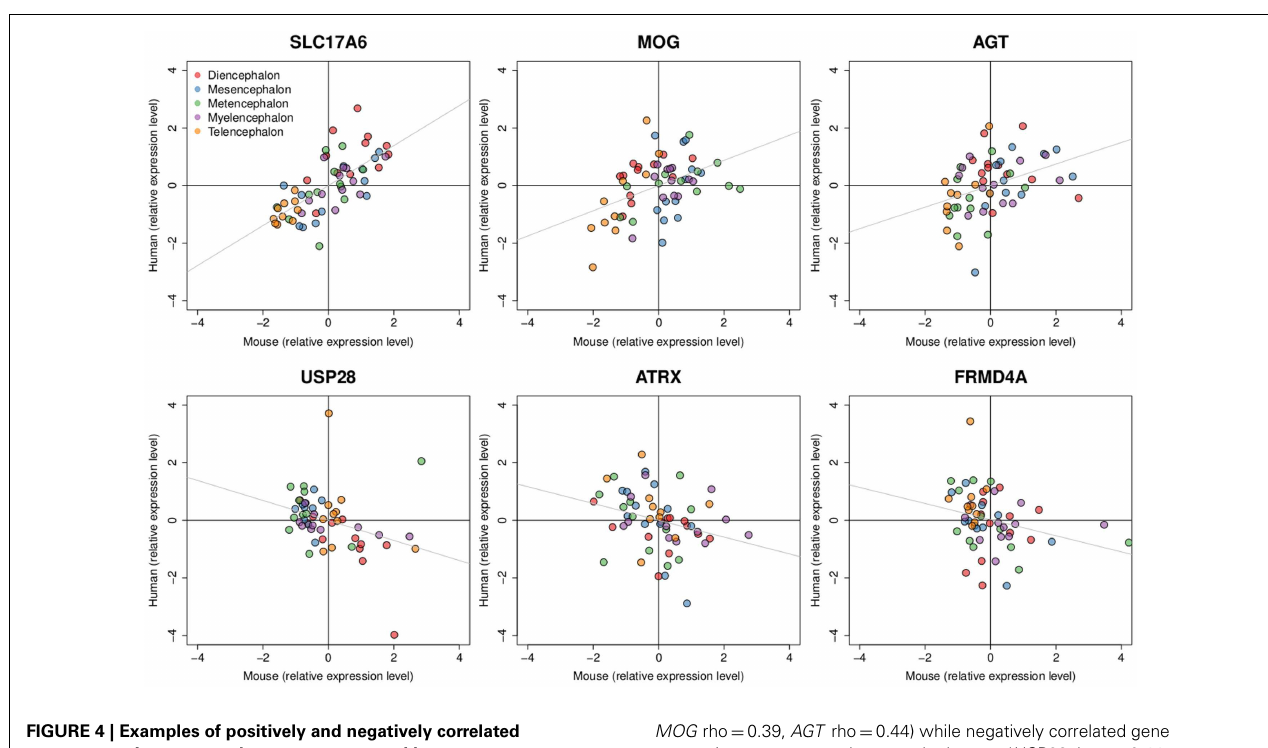
FIGURE 4 | Examples of positively and negatively correlated gene expression patterns between mouse and human H0351.2001. Dots represent brain region samples colored by major brain divisions.Three genes with expression patterns that are positively correlated are shown at the top ( SLC17A6 rho = 0.73,